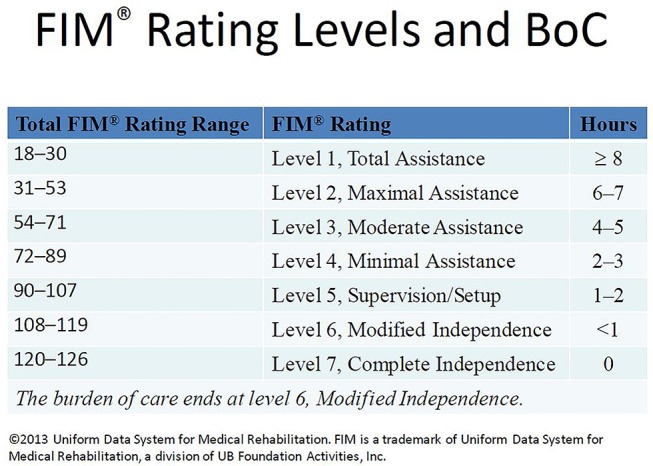
FIM rating levels and burden of care (BoC). This figure is a slide presented by Paulette Niewczyk, MPH, PhD, Director of Research, at UDSMR's 2013 Annual Conference in Orlando, Florida (Permission to reuse this slide was obtained from UDSMR in 2018).